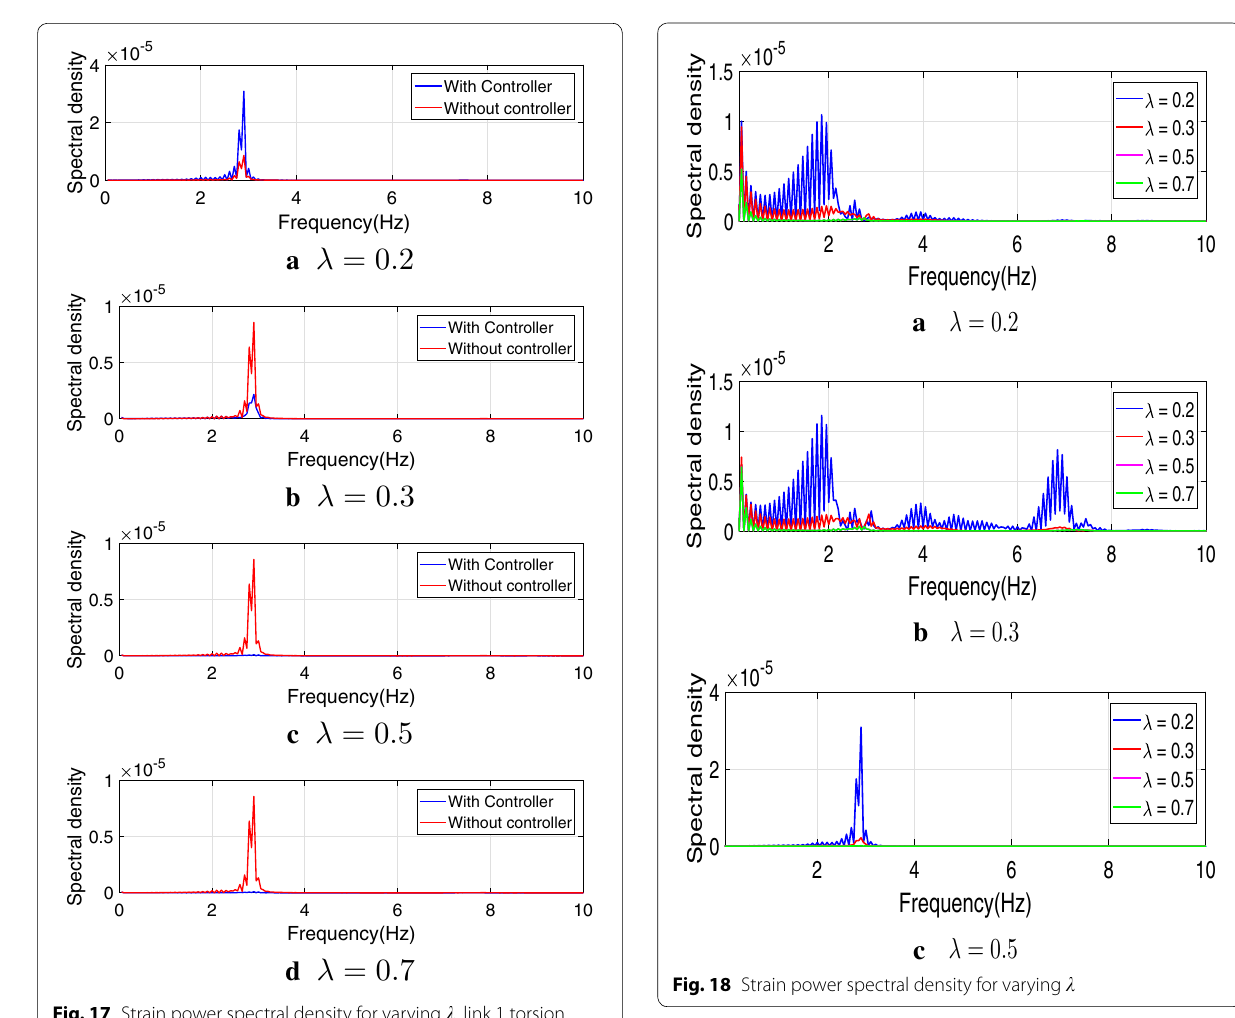
Fig. 17 Strain power spectral density for varying (cid:31) , link 1 torsion